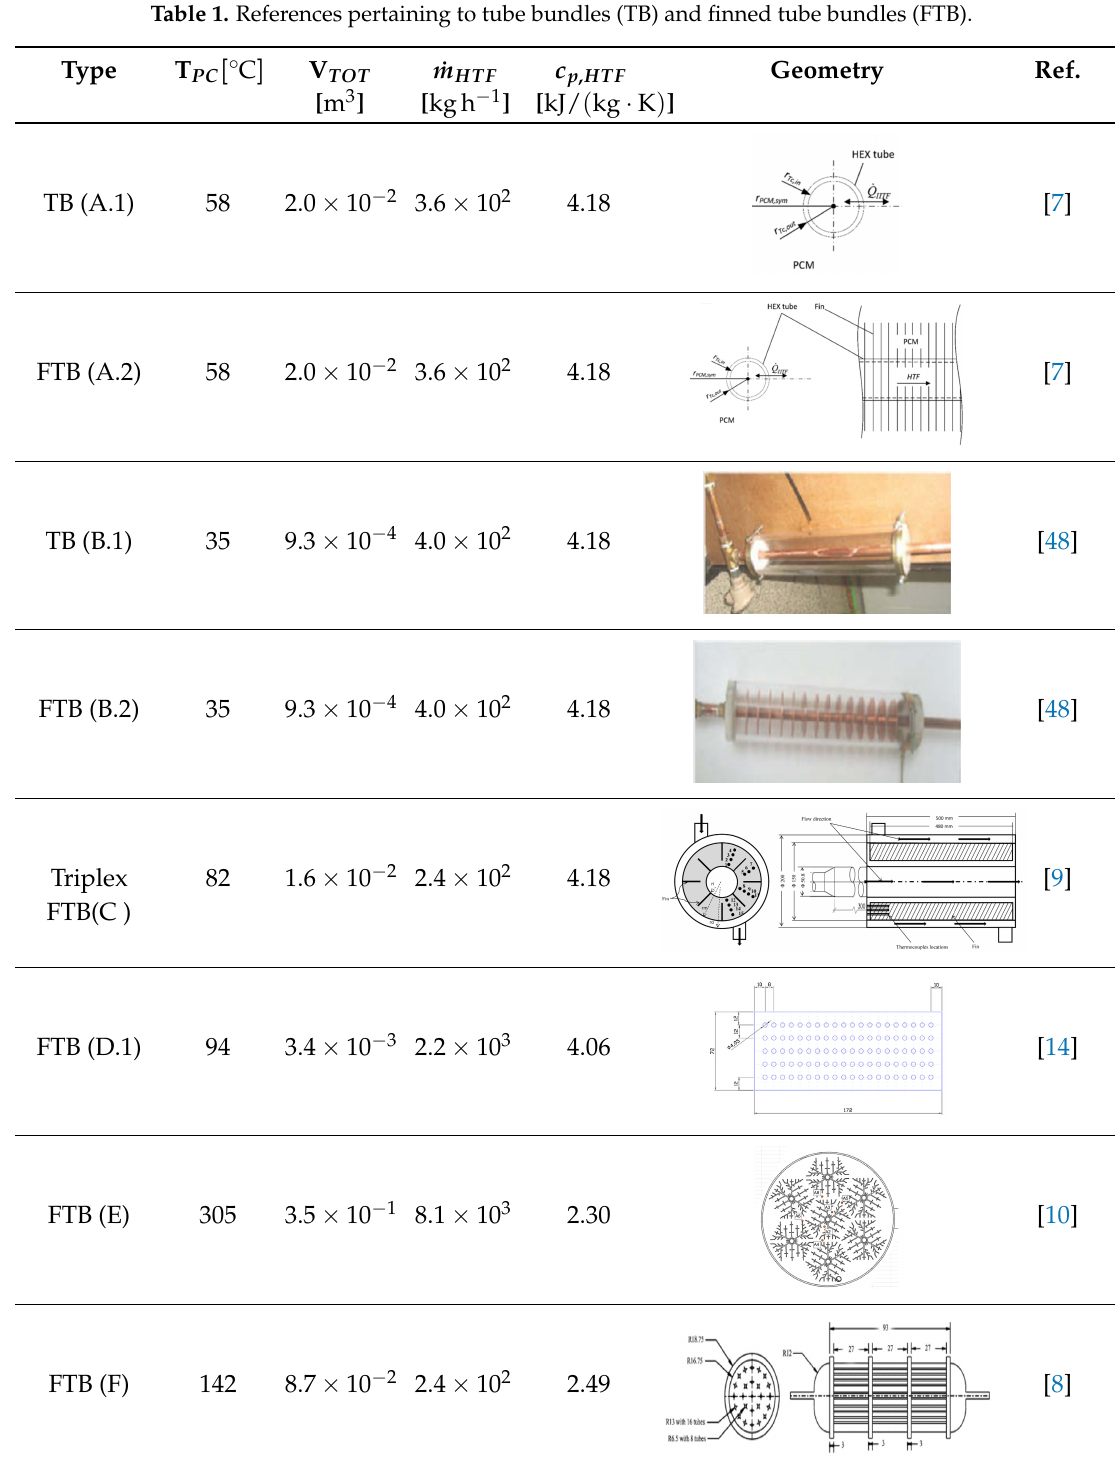
Table 1. References pertaining to tube bundles (TB) and finned tube bundles